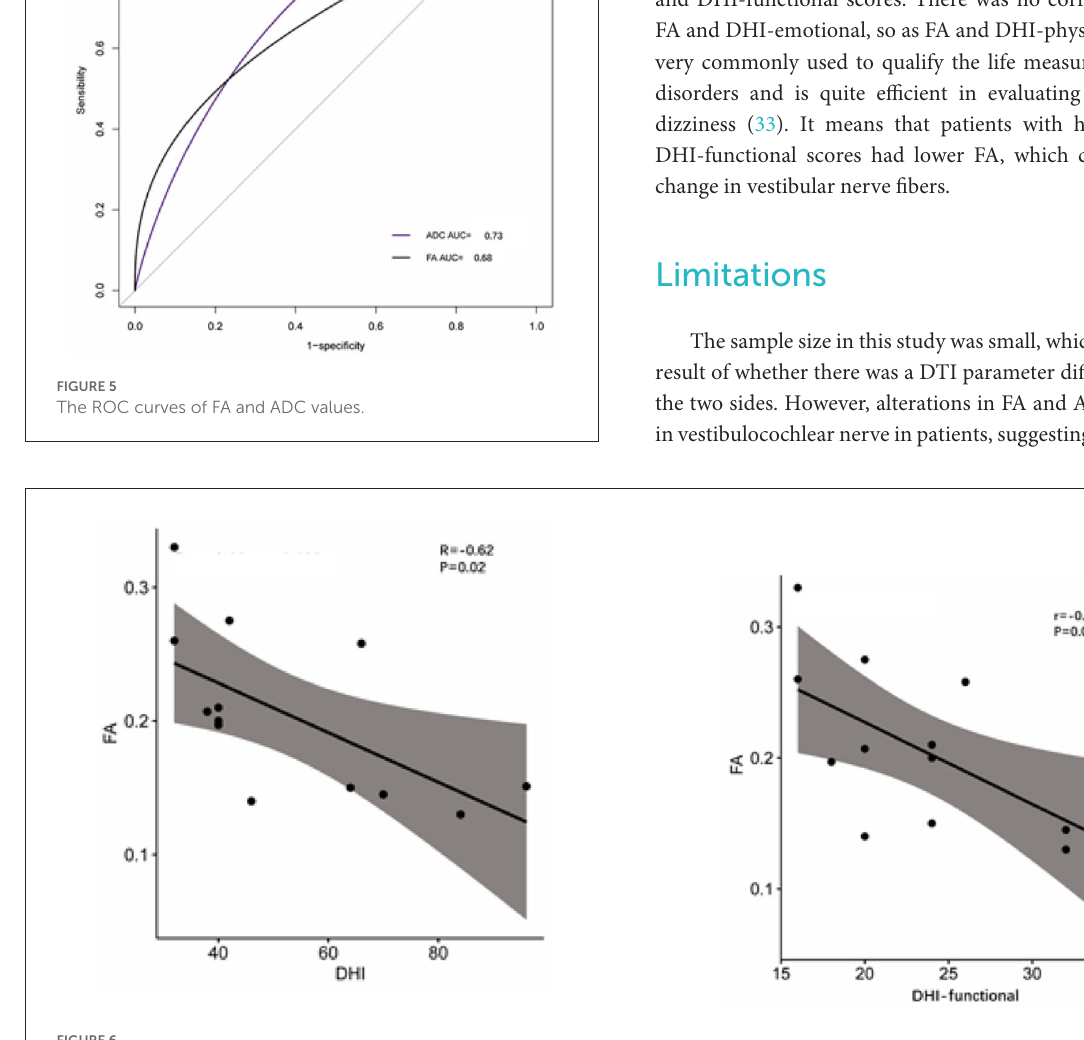
FIGURE6 Pearson correlation between FA and DHI and DHI-functional